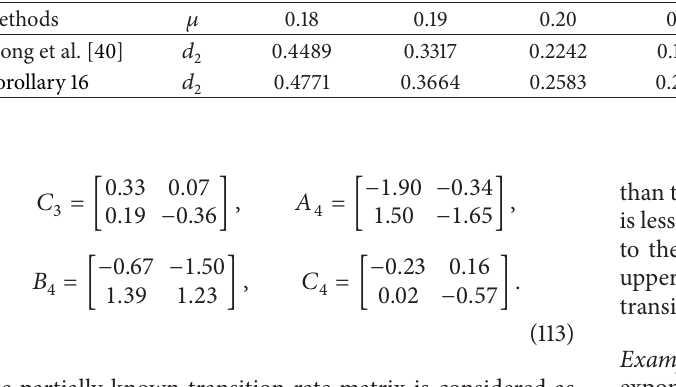
Figure 2: Retarded time-varying delay 𝑑 𝑖 (𝑡) at Mode 1, Mode 2, and Mode 3. Table 1: Maximum upper bound of 𝑑 2 with Π 1 and different parameter 𝜇